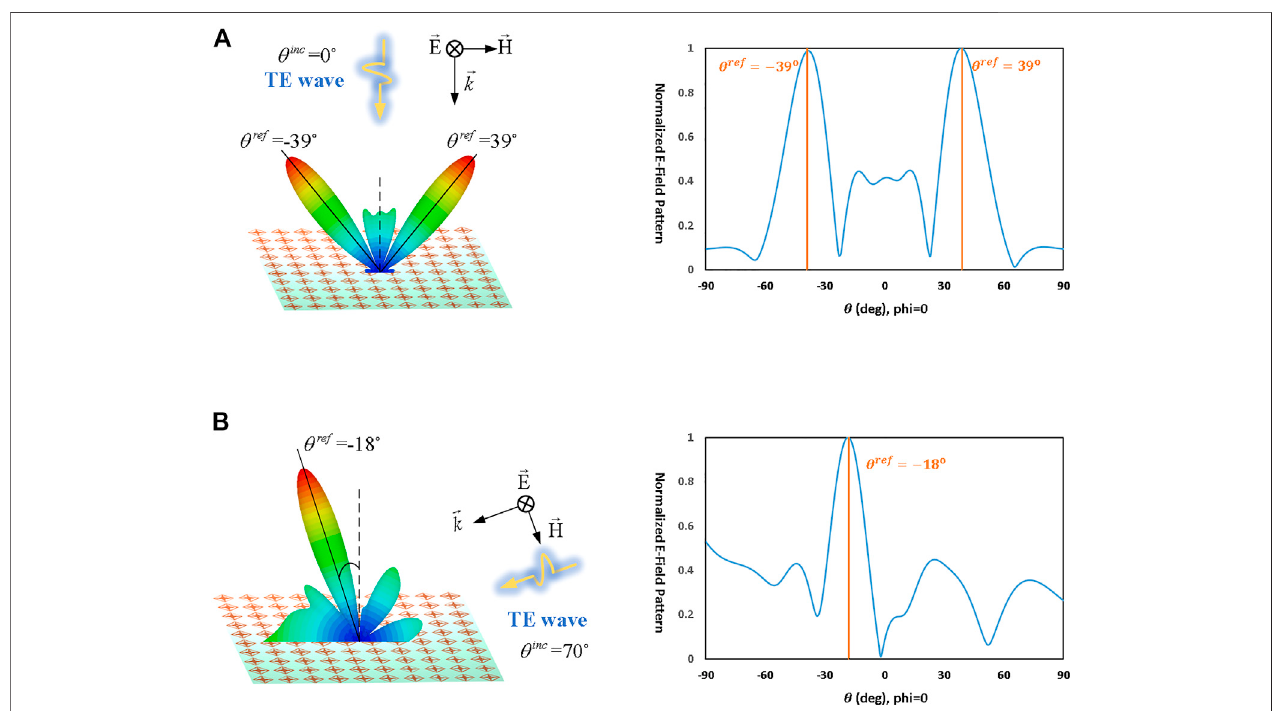
FIGURE6| Electrical fi eldpatternsoftheproposedprogrammablemetasurfaceunderdifferentincidentangles. (A) Normalincidence; (B) obliqueincidenceof70 o .